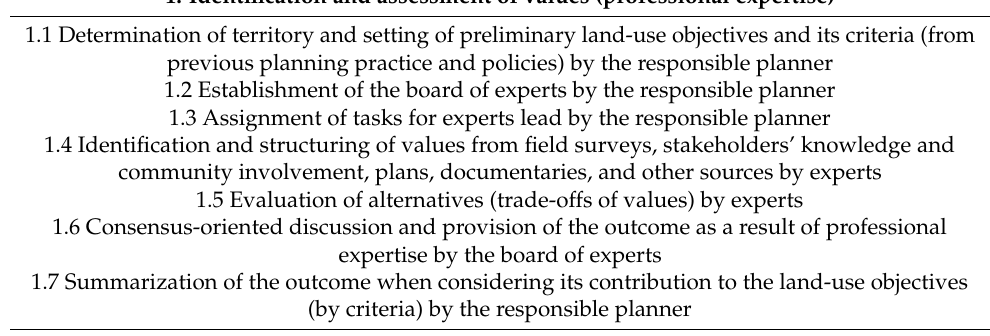
Table 2. Steps of